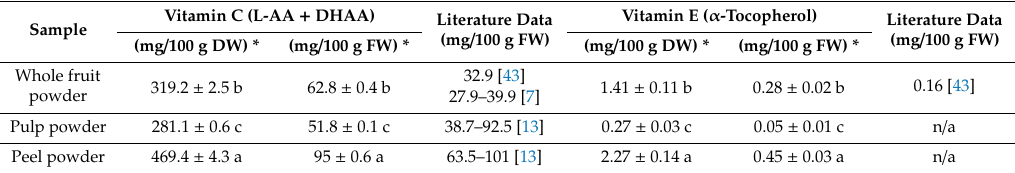
Table 6. Vitamin C and E in the powdered feijoa fruit samples.